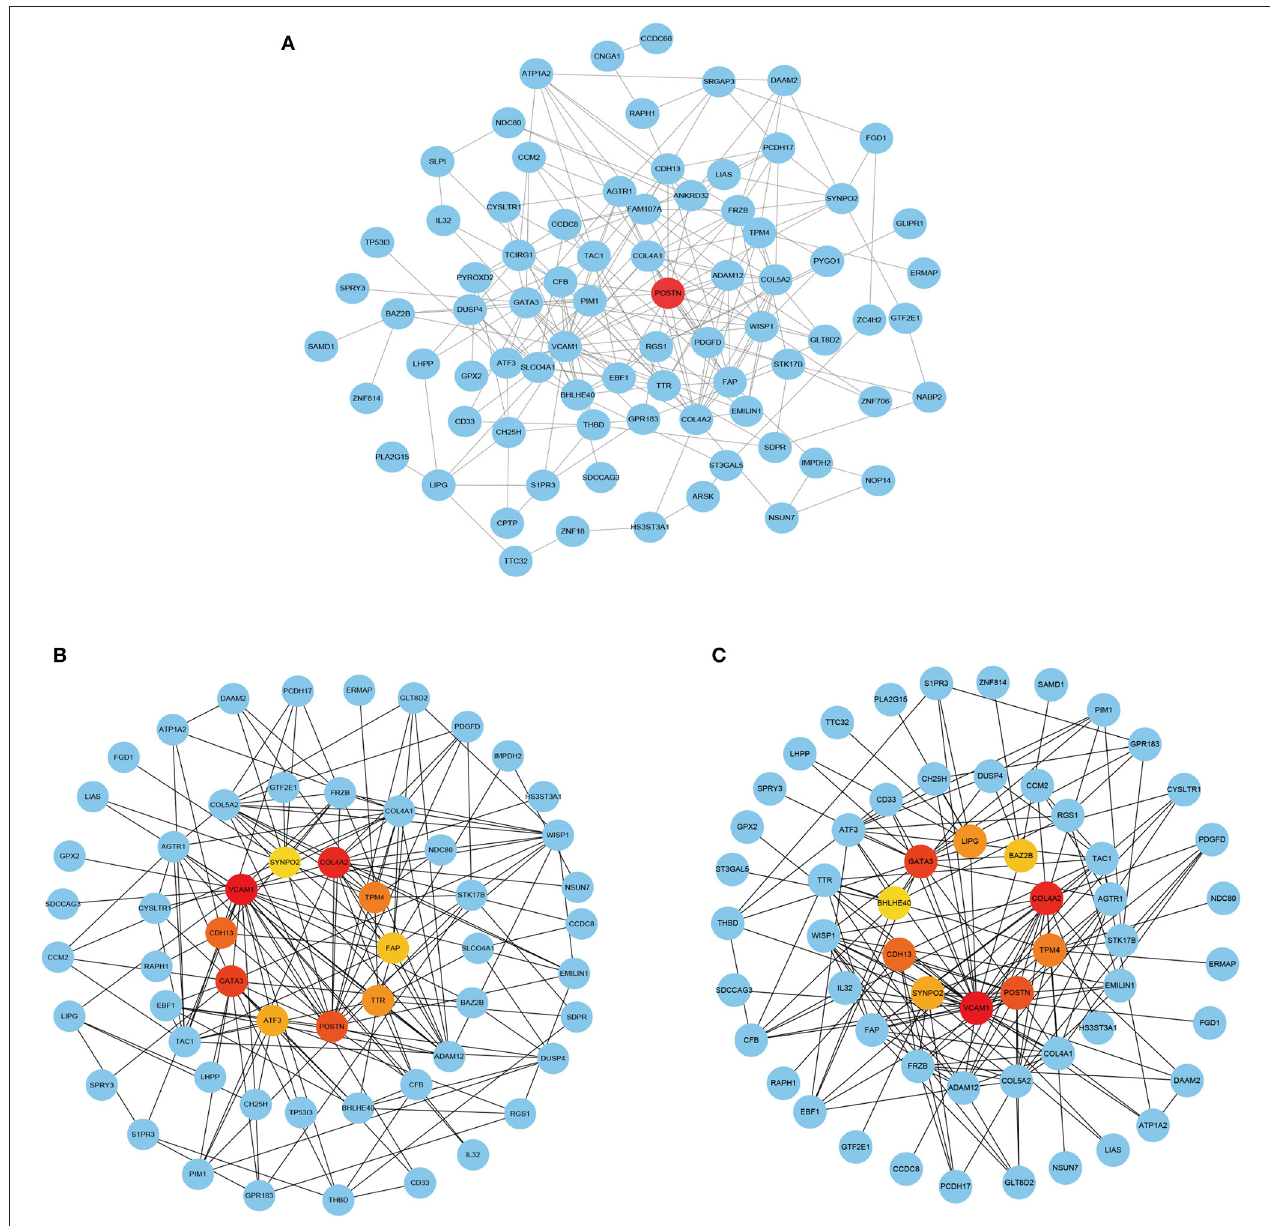
FIGURE 6 | PPI network analysis of POSTN in the royalblue module. (A) PPI network analysis of genes in the royalblue module. (B,C) Top 15 genes in the royalblue module identified by the stress (B) and betweenness (C) algorithms in